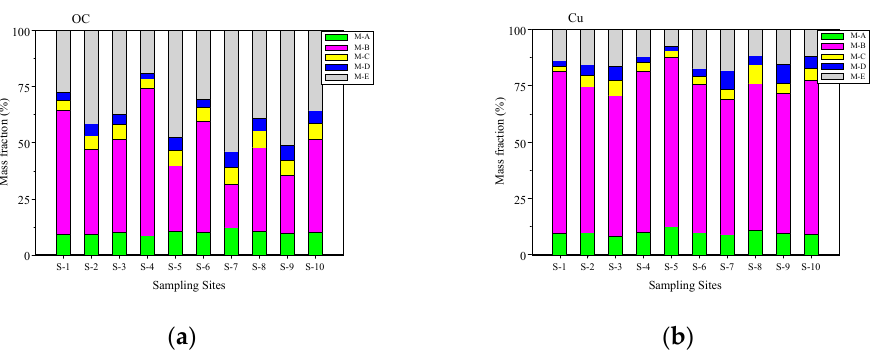
Figure 2. ( a , b ) The average Cu and OC mass percentages of the five size-fractioned AEOM solutions for each site. ( a ) OC and ( b ) Cu.